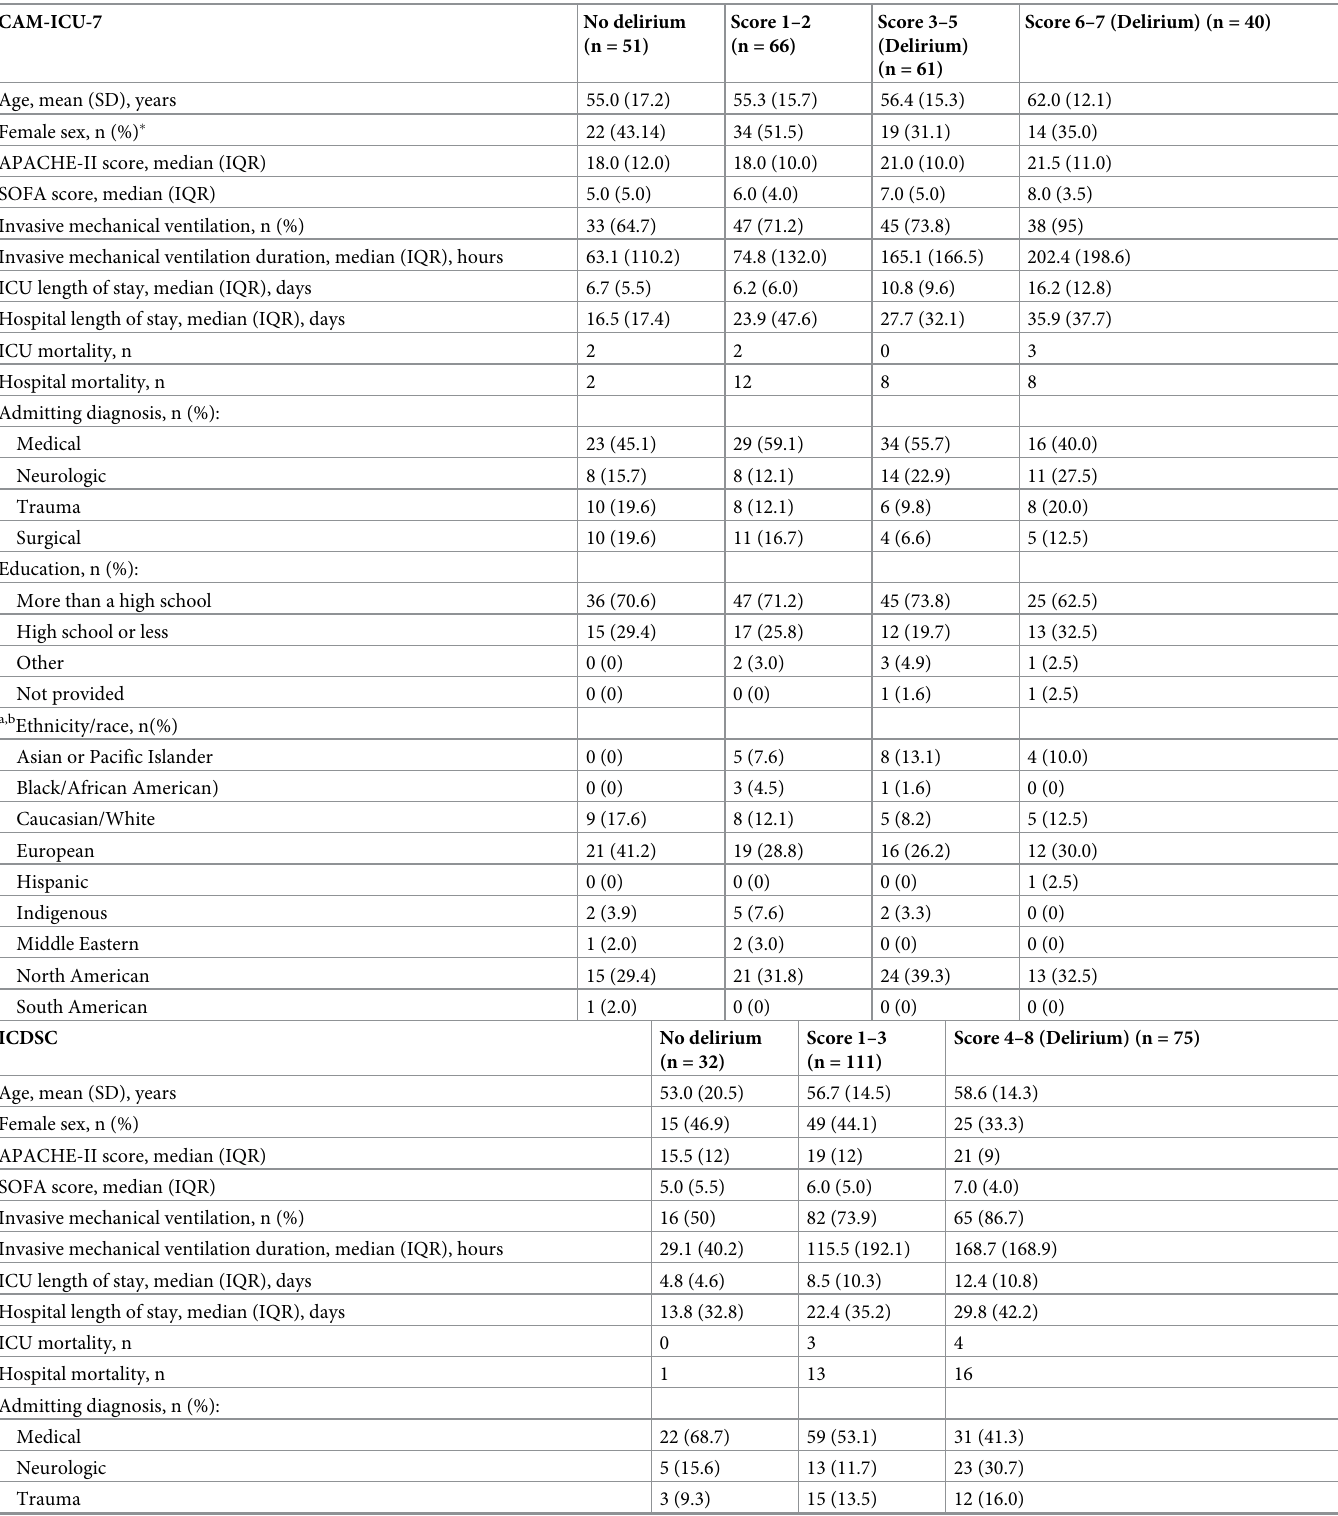
Table 1. Characteristics of the study sample (n =